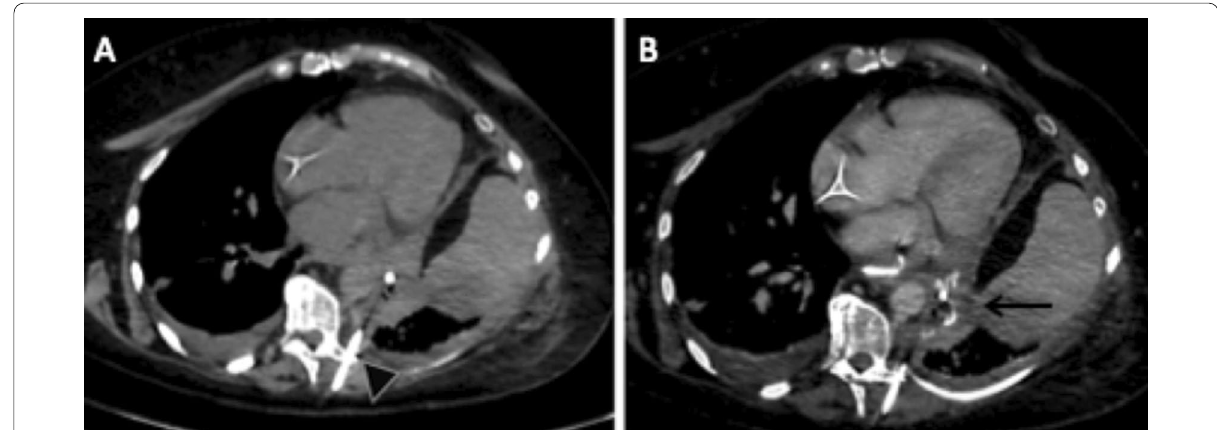
Fig. 13 Oesophagopleural fistula. Axial CT images (mediastinal window) without injection and without ingestion of iodinated contrast medium ( A ), with injection and ingestion of iodinated contrast medium ( B ). We note the absence of spontaneous hyperdensity of the pleural empyema, and its filling with iodinated contrast medium after ingestion (black arrow). A drain was already in the empyema at the time of CT acquisition (black arrowhead)